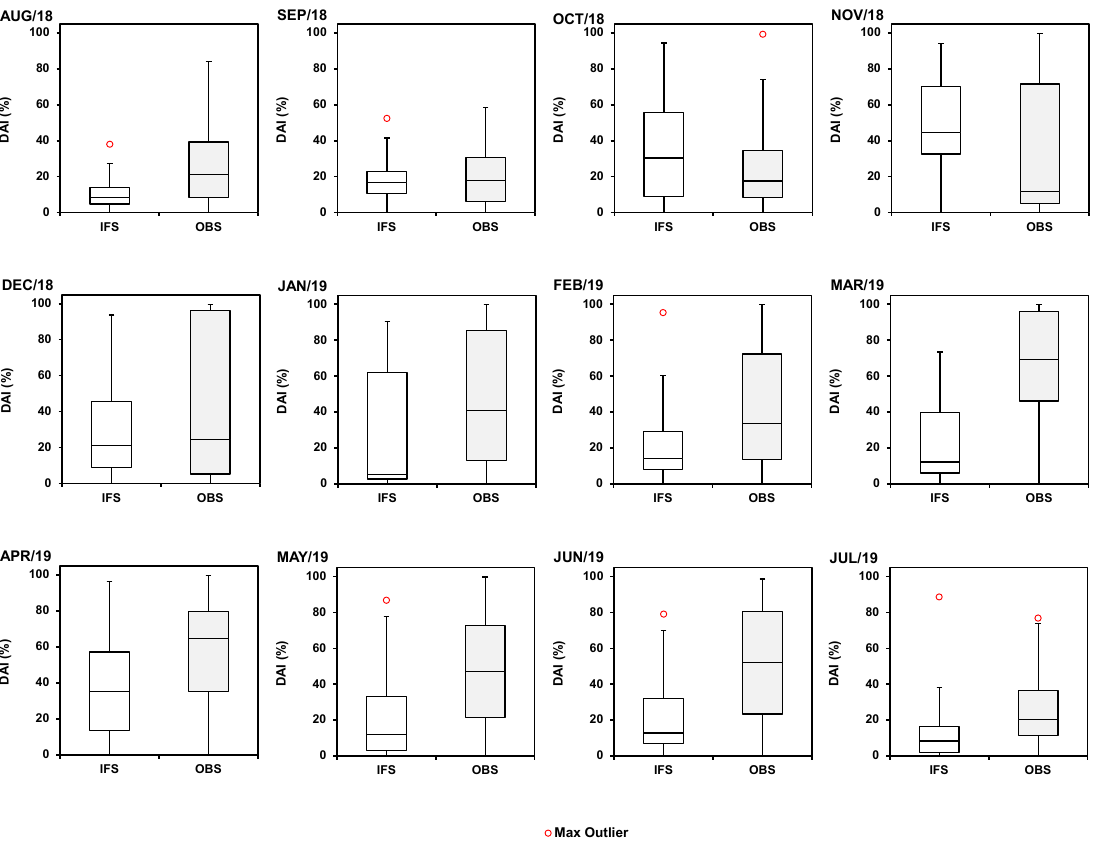
Figure 9. Monthly boxplots of daily mean values of DAI based on observations (OBS) and IFS/ECMWF forecasts (IFS), for Évora. The red circles represent outliers (maximum value).